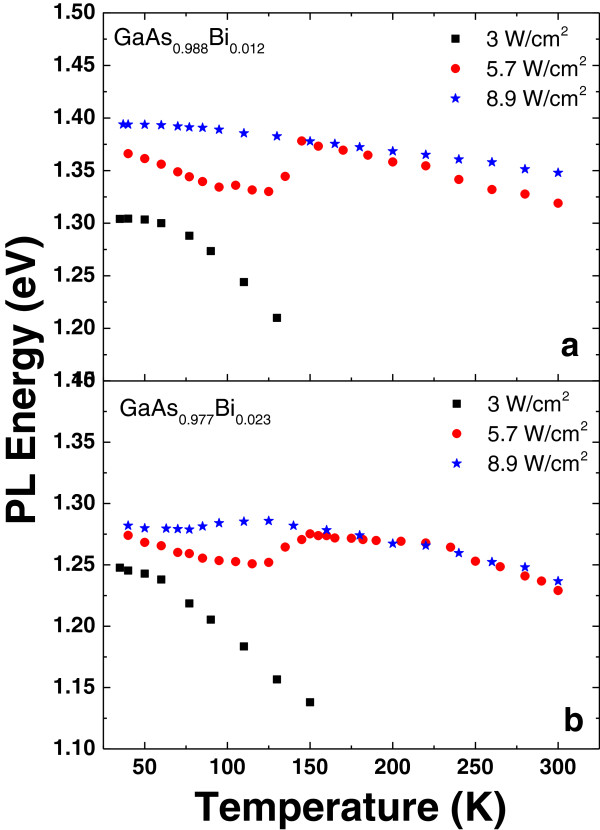
Temperature dependence of PL peak energy at various excitation intensities. (a) GaAs0.988Bi0.012. (b) GaAs0.977Bi0.023.